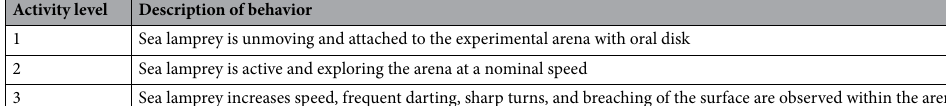
(Table 1). In high activity behaviors (score = 3), sea lampreys were moving at increased speeds and exhibiting be- haviors such as darting, turning sharply in the open arena, and breaching the water with their heads. In BORIS, each time an animal switched from the odor to non-odor side (or vice versa) the change in position was recorded as an event. The ‘post exposure to stimulus’ period was only recorded after confirmation that the fish interacted with the cue after its addition into the assay, and thus a trial was discarded if a fish spent the entire observation period without moving into the stimulus odor. Two metrics of response were calculated: preference and change in activity. To analyze preference, the proportion of time a sea lamprey spent on the stimulus side was calculated by dividing the time spent in the stimulus by the total time after the first encounter with the stimulus. A propor- tion of time equal to 50% indicated neutral preference, and a distribution less than 50% indicated avoidance. All statistical analyses were done in R (Version 1.4.1103). A Shapiro–Wilk’s test showed that the data followed a non- normal distribution, and a Levene’s test confirmed unequal variances, thus a Kruskal–Wallis test was performed to test for any effect of odor treatment on avoidance response. A post-hoc Dunn’s test (α = 0.05) was completed as a means comparison of preference responses. To analyze activity level, each time a fish exhibited a behavior described in the Ethogram (Table 1) was recorded. An activity index was calculated using the activity score for each individual sea lamprey by multiplying the amount of time spent on each behavior by its activity level and combining as follows: (time spent on high activity behaviors * 3) + (time spent on medium activity behaviors * 2) – (time spent on low activity behaviors *1). Activity indexes were separately calculated for pre-exposure (dur- ing the pre-stimulus trial observation period) and post-exposure (during the stimulus trial observation period). To account for individual differences in baseline activity rate, the change in activity was calculated for each fish by subtracting the pre-exposure activity index from the post-exposure activity index (Δ activity). A significantly larger index score was evidence of increased activity after odor exposure. In R, a one-way ANOVA was per- formed with Δ activity index as the response variable and odor type as a fixed effect. Normality was confirmed with a Shapiro–Wilk’s test (α = 0.05) and Tukey’s Honestly Significant Difference (HSD) (α = 0.05) was completed as a post-hoc means comparison for each treatment to understand the effect of odor on activity. Experiment 2: Behavioral responses by groups in a large arena assay. Videos of each trial were analyzed for pref- erence responses by pausing every 30 s and counting the number of fish on each side of the raceway (stimulus or non-stimulus, Fig. 1b) as an indication of preference. Fish positions were designated based on the location of a fish’s head at each 30 s-time stamp. Positions were quantified during the pre-stimulus period (i.e., the 10-min acclimation period) and during the post-stimulus period, defined as the final 10 min of the observation period. This ensured that the introduced stimulus ran to the end of the experimental arena and allowed adequate time for the distribution of fish to stabilize after encountering an odor. Activity levels could not be scored in this experiment because individual fish within the group could not be identified from the video. All statistical analy- ses were done in R (Version 1.4.1103). A Shapiro–Wilk’s test confirmed data followed a non-normal distribution, and a Levene’s test confirmed unequal variances. A Kruskal–Wallis test was performed to test for any effect of odor treatment on avoidance response and post-hoc Dunn’s test (α = 0.05) was completed as a means comparison of preference responses. Putrescine, putrescine + petromyzonacil, and 10 –1 M putrescine treatment means were compared to two alarm cue treatments (full body extract and crude skin extract) and solvent controls means to determine if putrescine elicited a partial, full, or not-significant avoidance response in sea lamprey. Results Experiment 1: Behavioral responses by individuals in a small-arena assay.